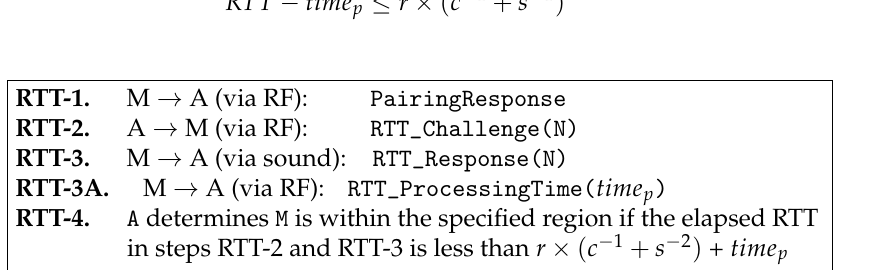
Figure 7. RTT-based distance verification protocol with considering the processing time, time p , for each